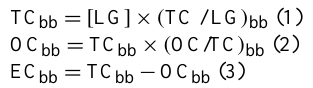
Table 2). Notation: TC=total carbon;